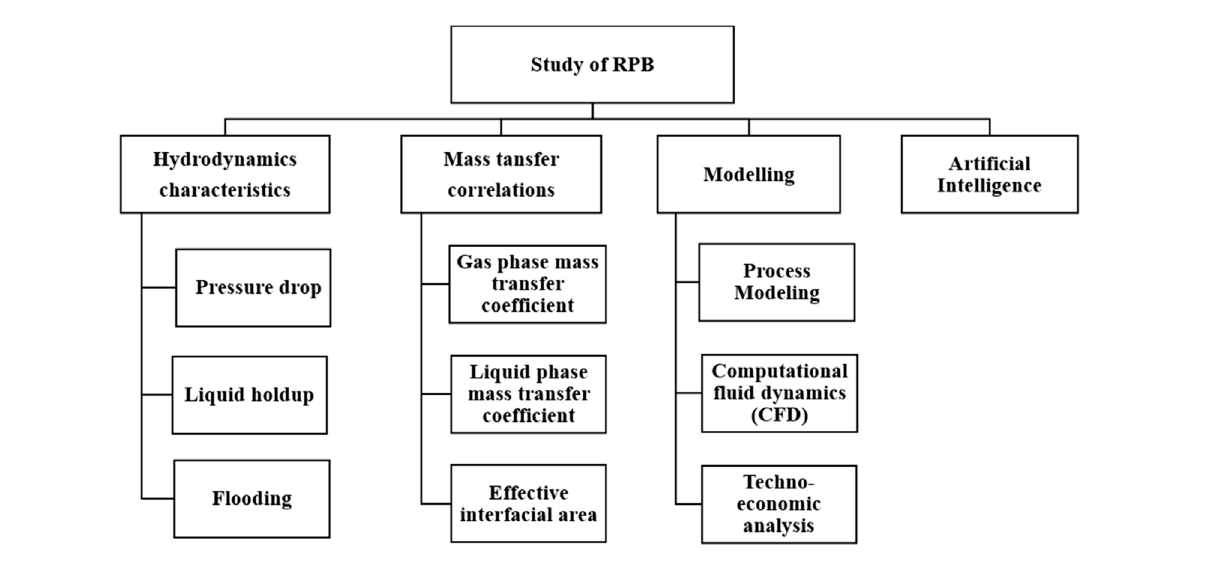
TABLE 1 Modeling approaches for